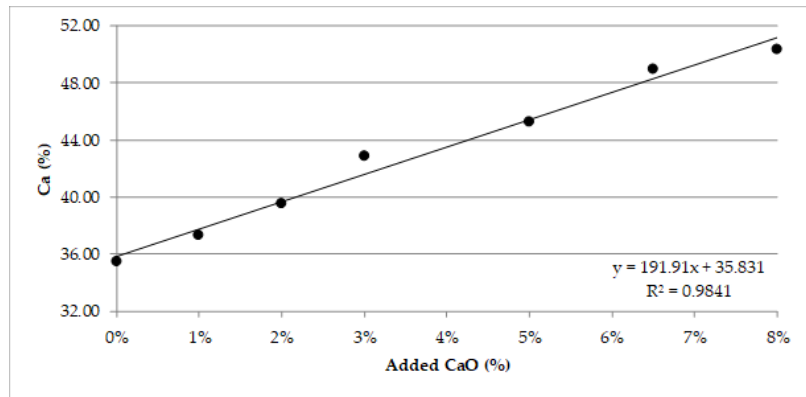
Figure 16. After-treatment Ca content vs. added quicklime.